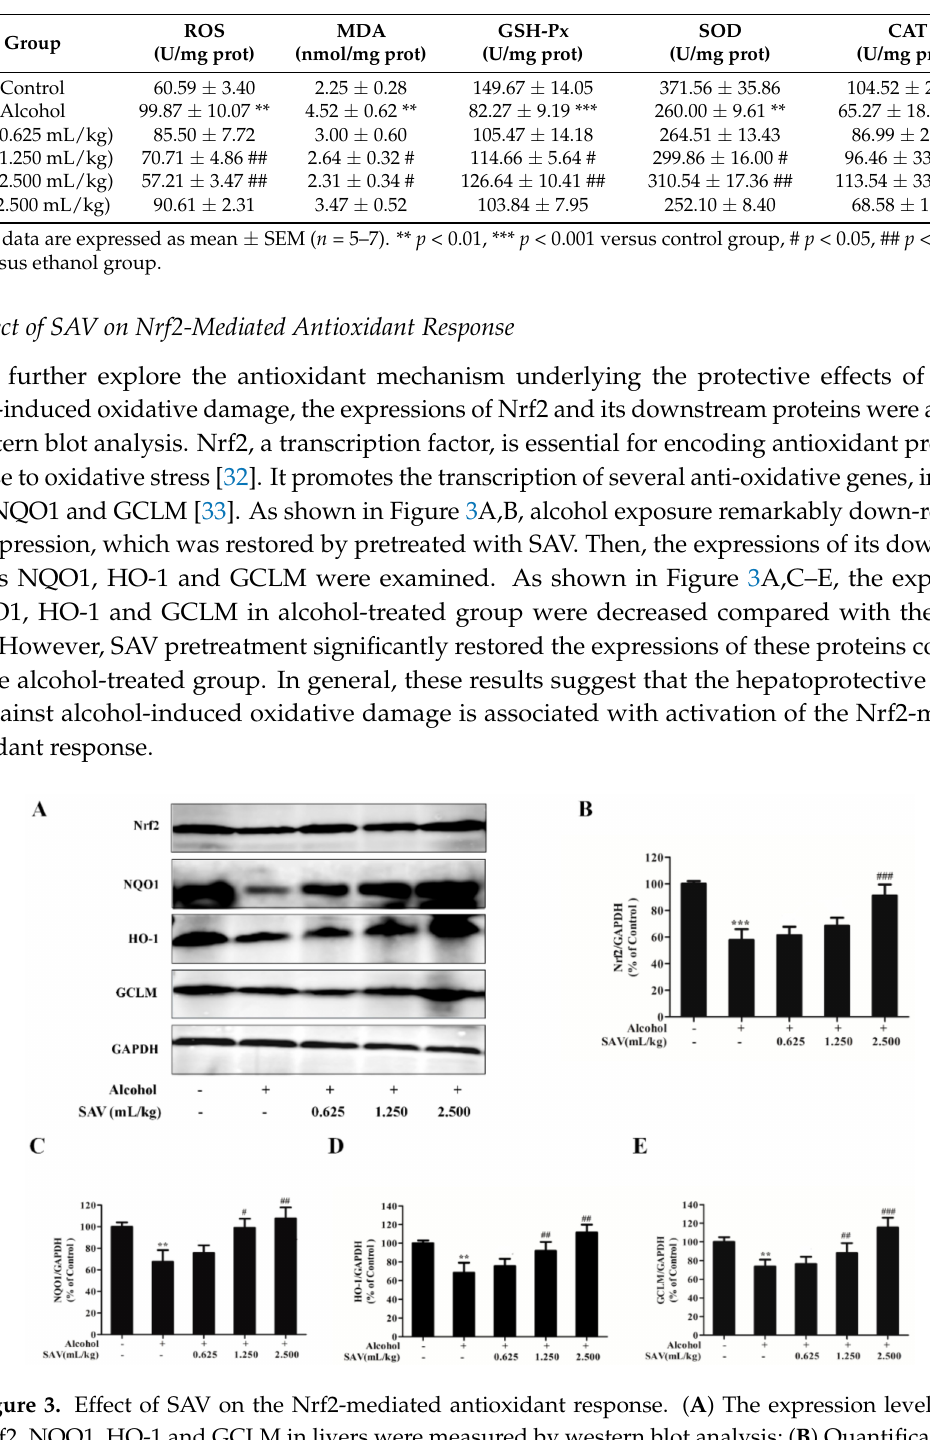
Table 1. Hepatic levels of ROS and MDA and antioxidant enzymes in mice.